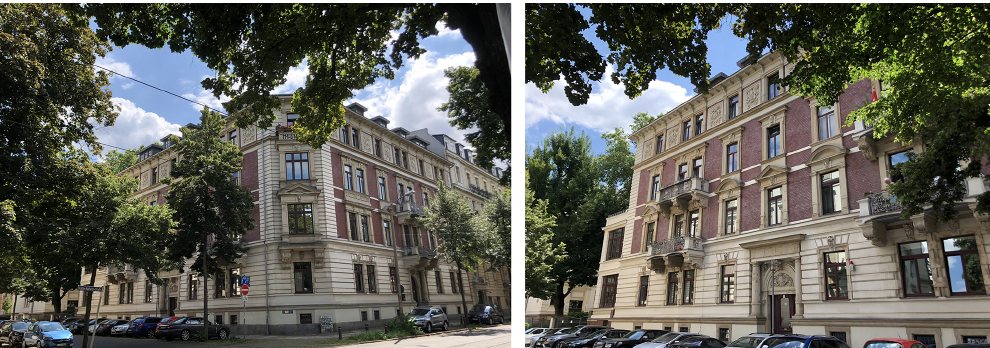
Figure 9. On the left is the corner house on Hillerstraße 9, and Plagwitzer Straße 7 is shown on the right (today named Käthe-Kollwitz- Straße). Günther Thiem had his offices at Plagwitzer Straße 9 (yellow building to the right) from 1915 and finally moved to Plagwitzer Straße 7 in 1939 (right). Hillerstraße 9 was the Thiem family residence, and Adolf and his family lived on the second floor from 1887, while Günther took over the residence in 1909 (photos: Georg